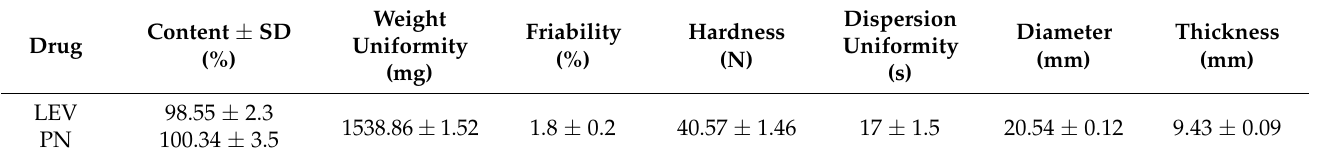
Table A1. Weight uniformity, API contents, friability, hardness, disintegration time and dimensions of 3D-printed compound LEV-PN multicompartmental structure dispersible tablets (mean ± SD, n =